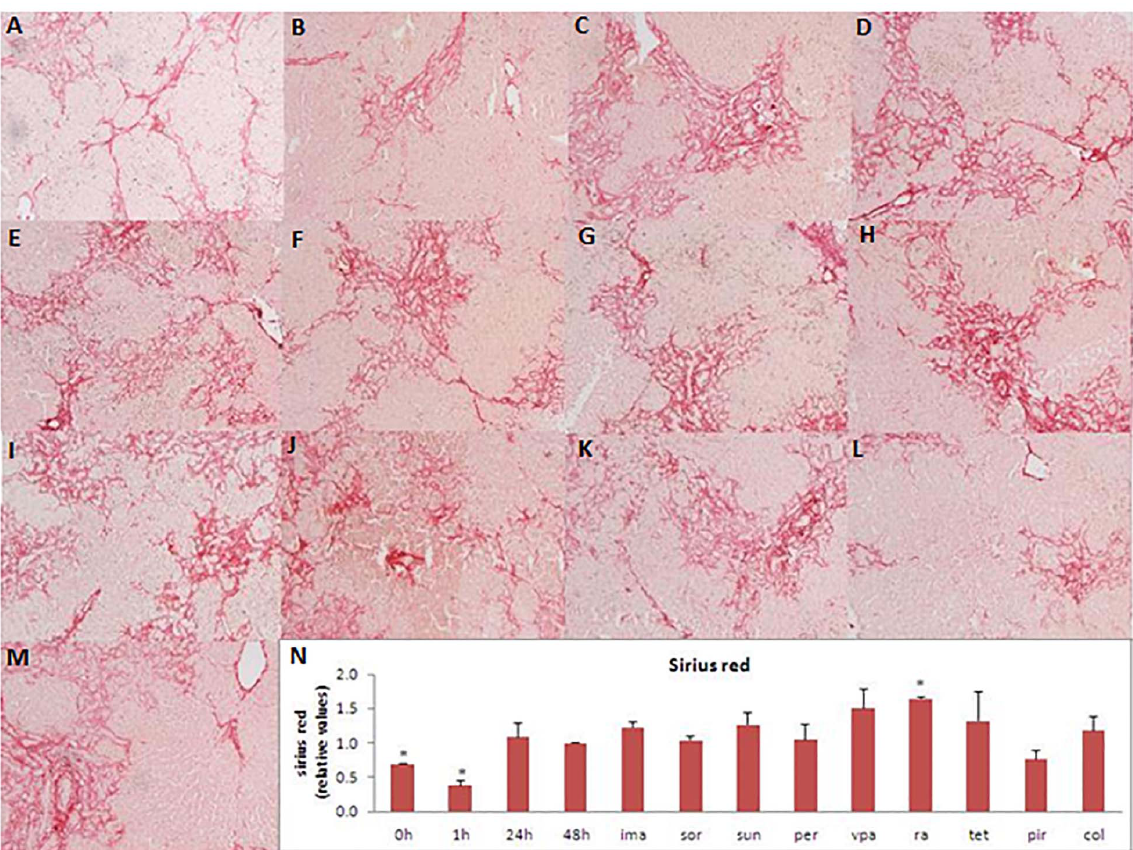
Figure 2. Sirius red staining of control fPCLS and fPCLS incubated with antifibrotic drugs. Sirius red staining on paraffin embedded, formalin fixed fibrotic PCLS directly after slicing (A), incubated for 1 hour (B), 24 hours (C) and 48 hours (D) and incubated for 48 hours with the compounds imatinib (ima) (E), sorafenib (sor) (F), sunitinib (sun) (G), perindopril (per) (H), valproic acid (vpa) (I), rosmarinic acid (ra) (J), tetrandrine (tet) (K), pirfenidone (pir) (L) and colchicine (col) (M).Quantification of sirius red staining (N). n=3. Error bars represent SEM. *p , 0.05 vs 48 hours.